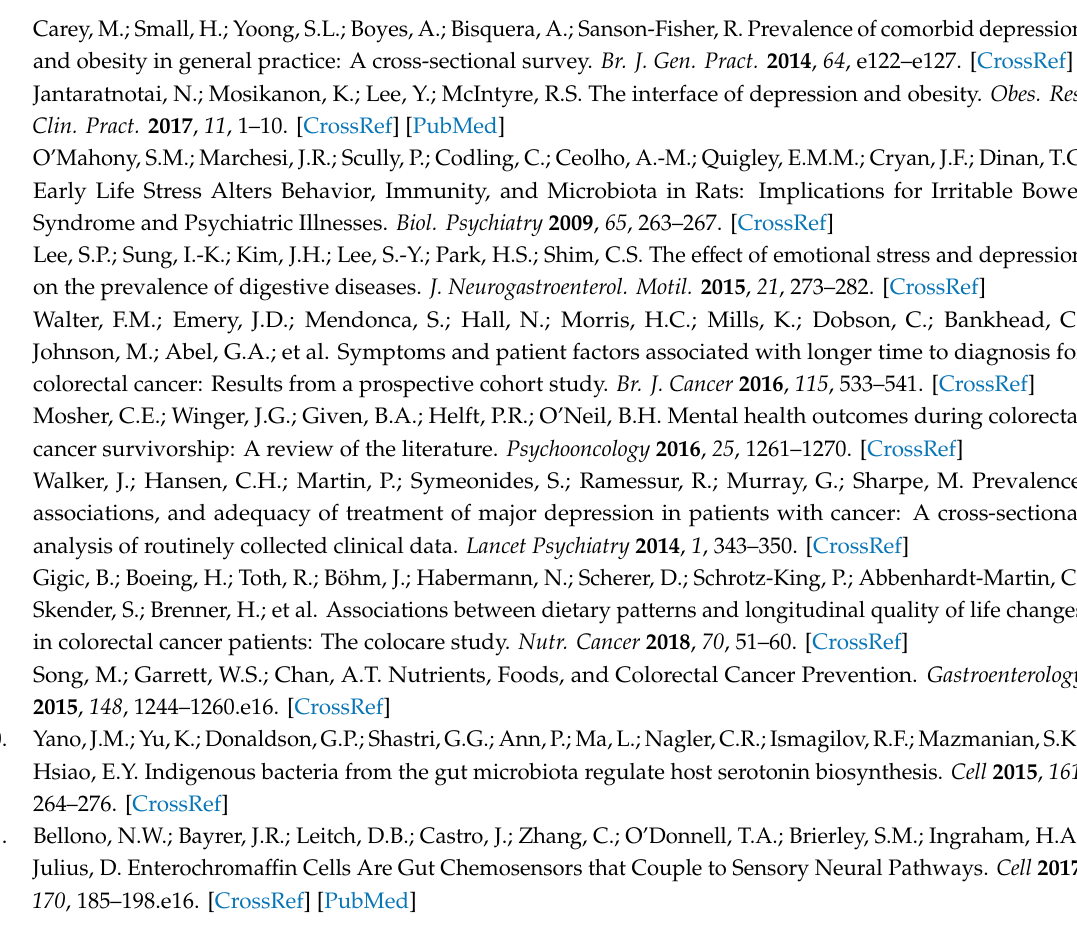
Table S1: Calibration curve range of linearity, coe ffi cient of correlation, limit of quantification, LOQ, matrix e ff ect and retention time stability in plasma and urine; Table S2: Recovery and precision at low, medium and high spiked concentrations in plasma and urine; Table S3: stock solution and spiked concentrations (low, medium and high) used for recovery and precision assays in plasma and urine. Table S4: Metabolite concentration ranges detected in plasma and urine compared to reference data. Figure S1: Chromatogram of 13 standard compounds obtained with RP and HILIC chromatography. Figure S2: Chromatogram of the most polar metabolites obtained on five di ff erent C 18 analytical